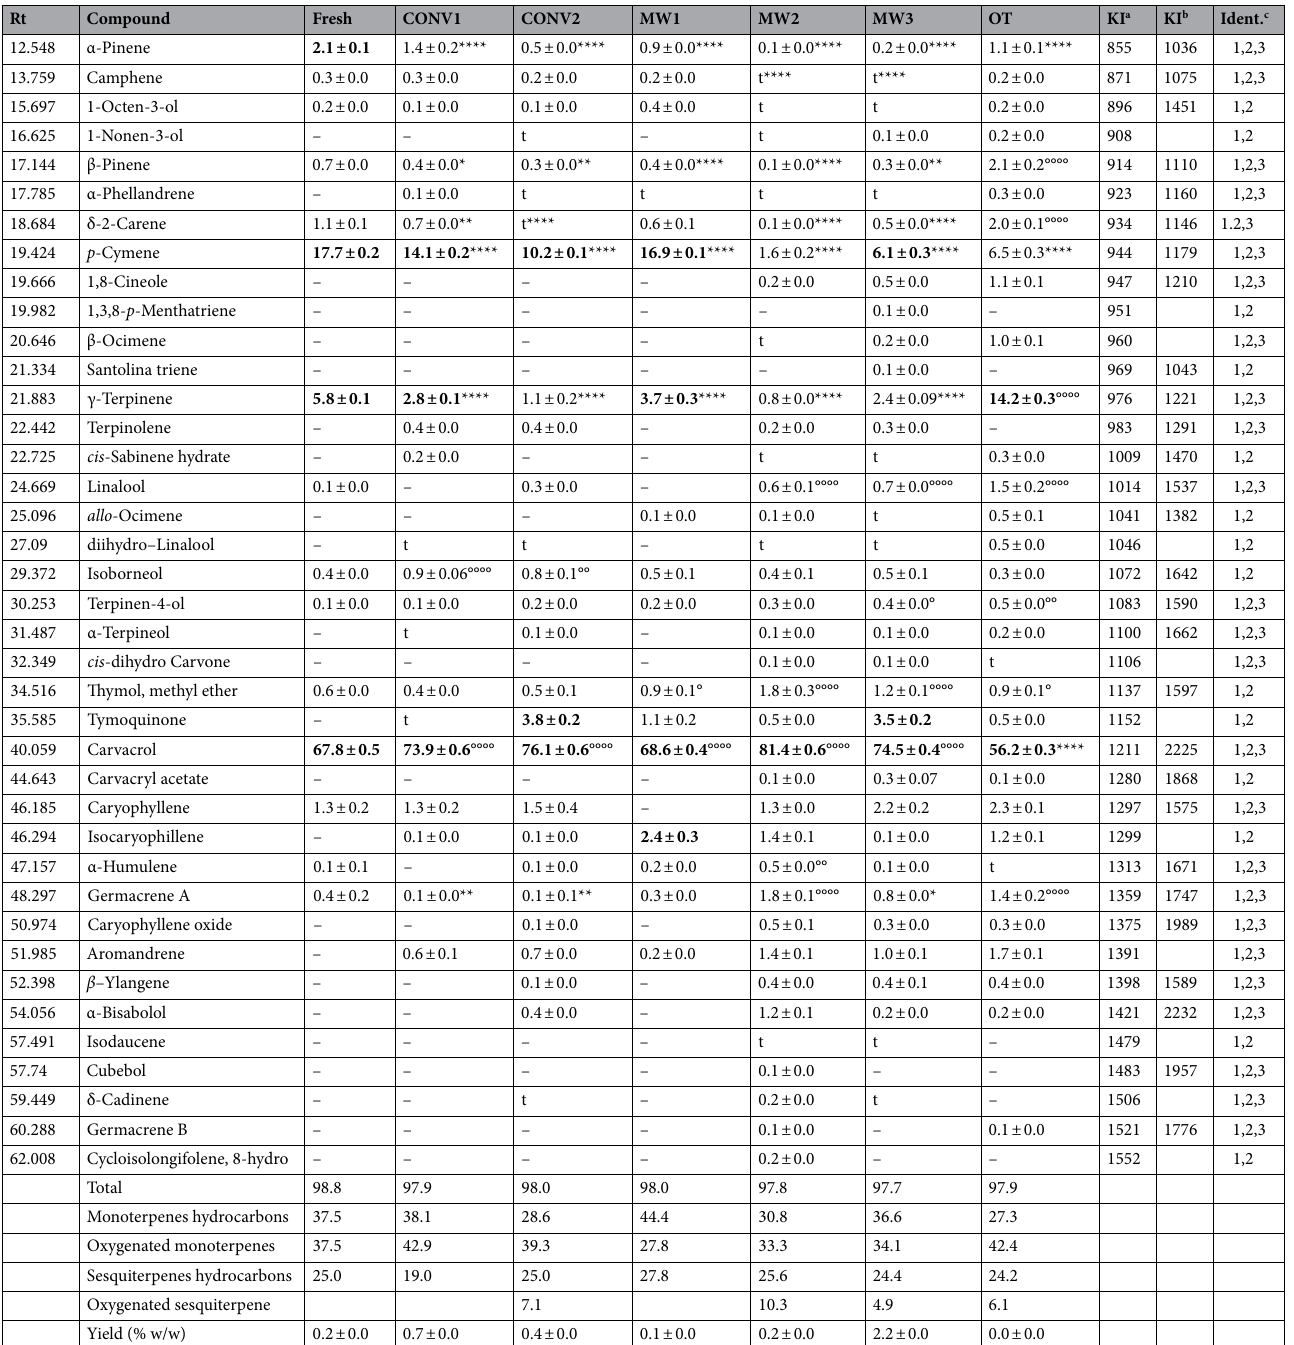
Table 1. Effects of different drying methods on the essential oil composition of Origanum vulgare . Results are expressed as mean percentage ± standard deviation of three independent determinations. Significant values are in bold. *Significantly different at p value < 0.05, **p value < 0.01; ***p value < 0.001; ****p value < 0.0001 vs. fresh; °significantly different p value < 0.05; °°p value < 0.01; °°°p value < 0.001; °°°°p value < 0.0001 vs. fresh; a,b are the Kovats retention indices determined relative to a series of n -alkanes (C 10 –C 35 ) on the apolar HP-5 MS and the polar HP Innowax capillary columns, respectively; c identification method: 1 = comparison of the Kovats retention indices with published data; 2 = comparison of mass spectra with those listed in the NIST 02 and Wiley 275 libraries and with published data; 3 = coinjection with authentic compounds; c -: not detected; t = trace (<